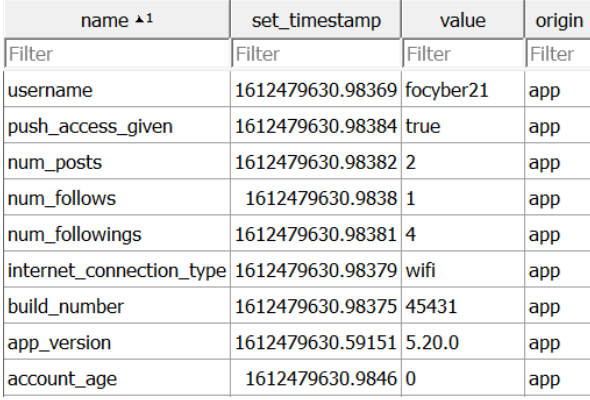
Figure 18. User profile attributes as recovered from the Dubsmash iOS app.